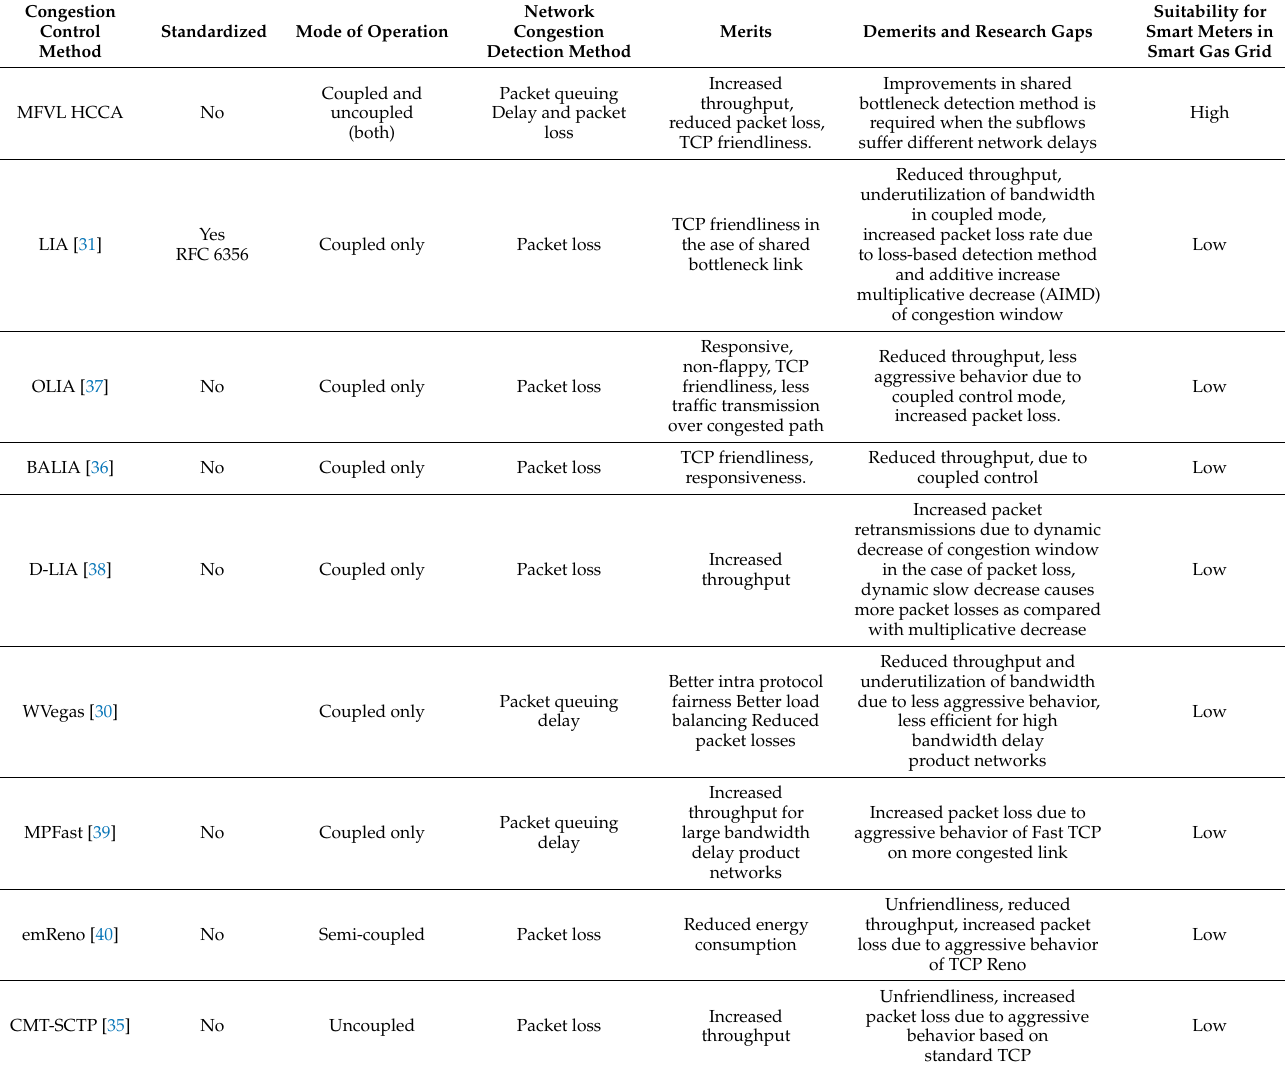
Table 2. Comparison of existing multipath transmission control protocol (MPTCP) congestion control algorithms with the modified Fast-Vegas-LIA hybrid congestion control algorithm (MFVL